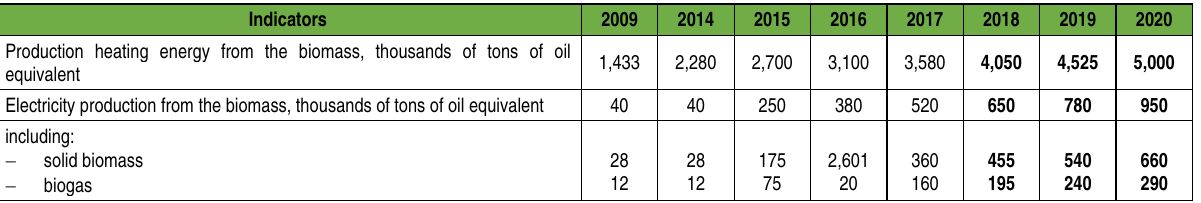
Table 3. The Ukrainian indicative goals of biomass in gross energy consumption by 2020 Indicators